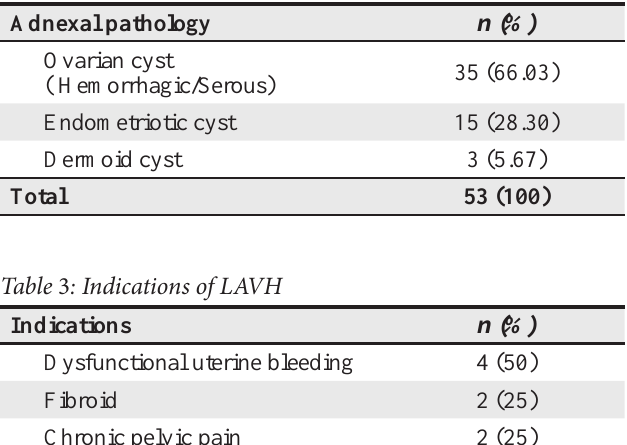
Table 2 : Type of adnexal pathology operated on